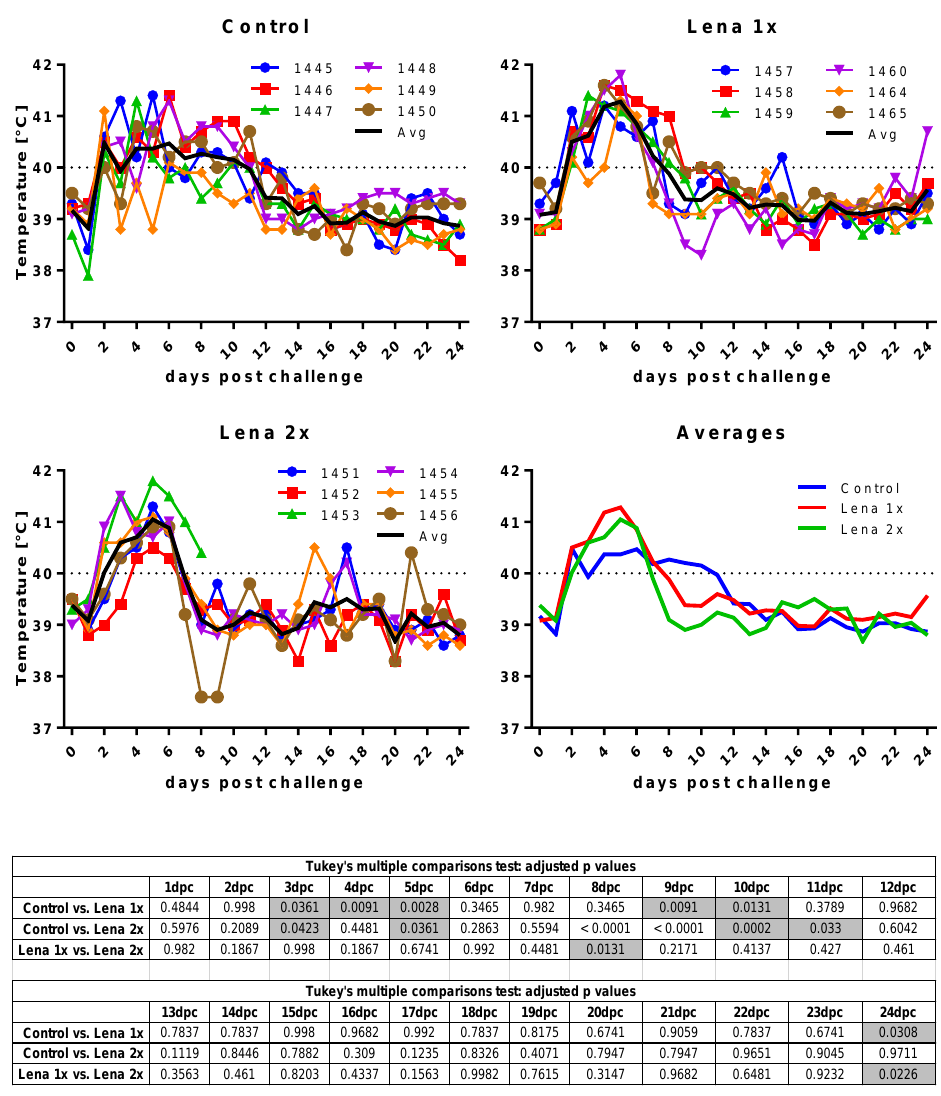
Figure 2. Body temperature after challenge. Control, Lena 1x, and Lena 2x: Colored lines represent individual animals and thick black lines represent the mean value for each group. Temperature > 40 ◦ C was considered as fever (dotted line on upper panel). dpc—days post-challenge. Statistical analysis was performed with an ordinary 2-way ANOVA, followed by Tukey’s multiple comparison test. Statistically significant values are highlighted in grey in the table under the graphs.